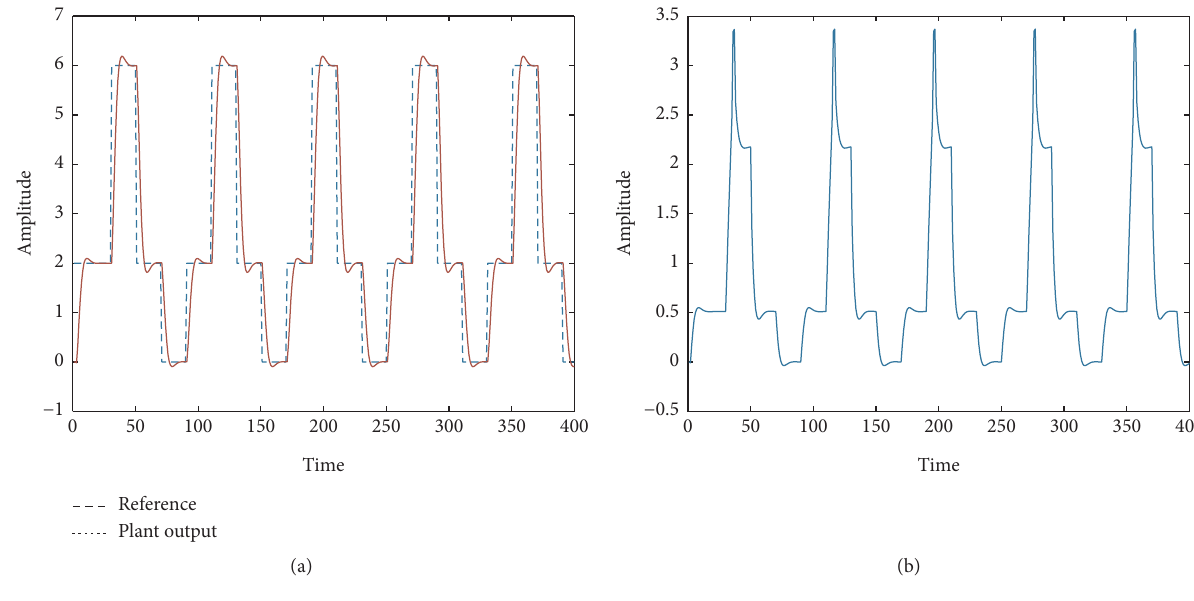
Figure 9: (a) Plant output. (b) Control